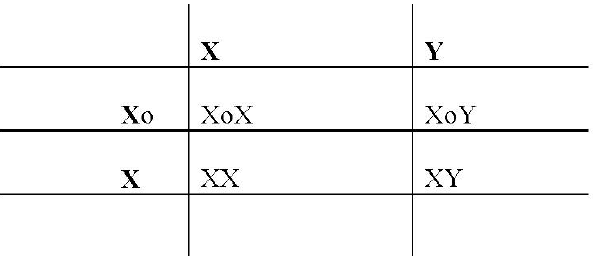
Figure 5. X-linked maternal dominant: There is 25% chance that females will not inherit the mutation, a 25% chance of hav- ing a female who inherits the mutation, a 25% chance of having an unaffected son and a 25% chance that males will be affected.